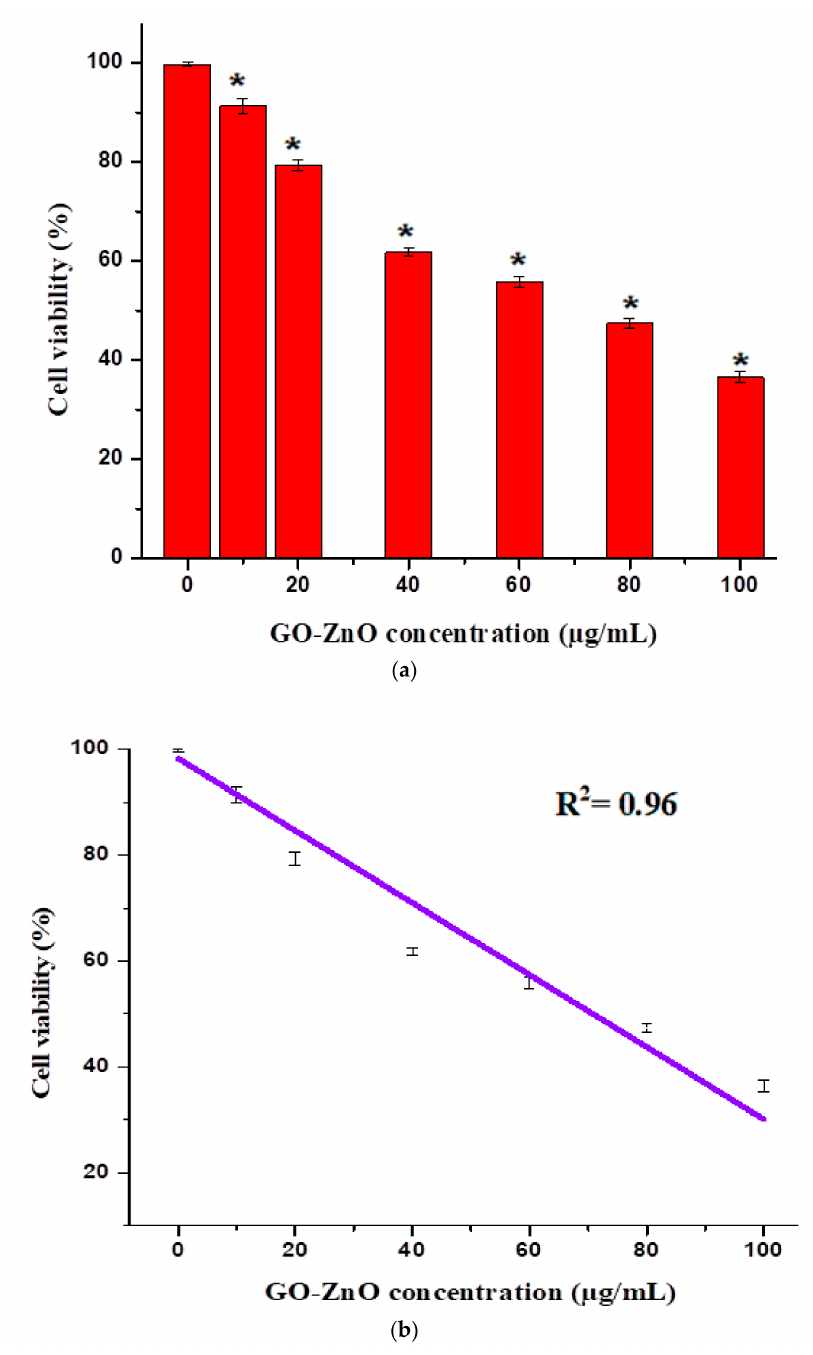
Figure 6. ( a ) cellular viability of GO-ZnO treated MCF-7 cells, t -test (* p < 0.05); ( b ) linear calibration plot of GO-ZnO vs. cell